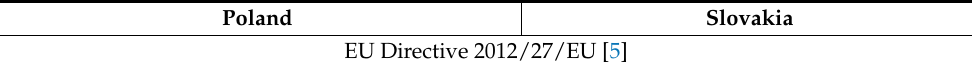
Table 1. Legal acts and strategic documents on increase in energy efficiency in Poland and